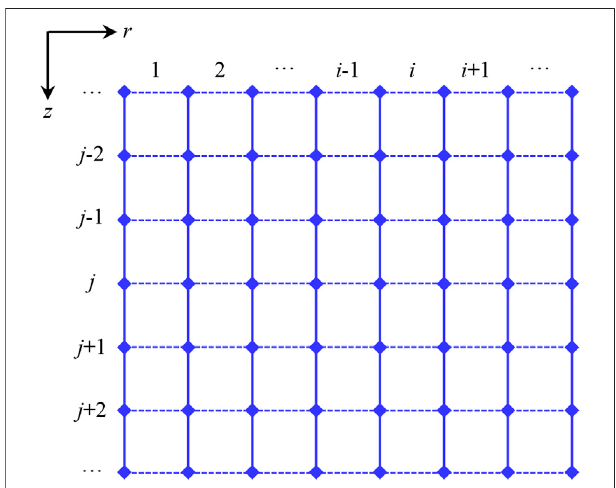
FIGURE 2 | Schematic diagram of two-dimensional mesh division of wellbore and seawater or